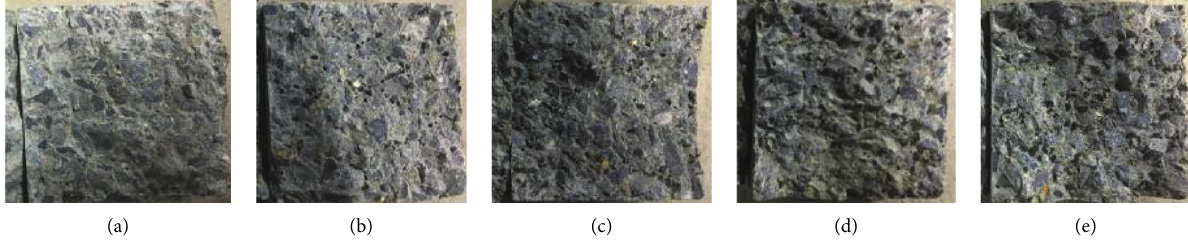
Figure 5: Splitting failure modes of rubber concrete with different substitution rates. (a) 0%, (b) 10%, (c) 20%, (d) 30%, and (e) 40%.